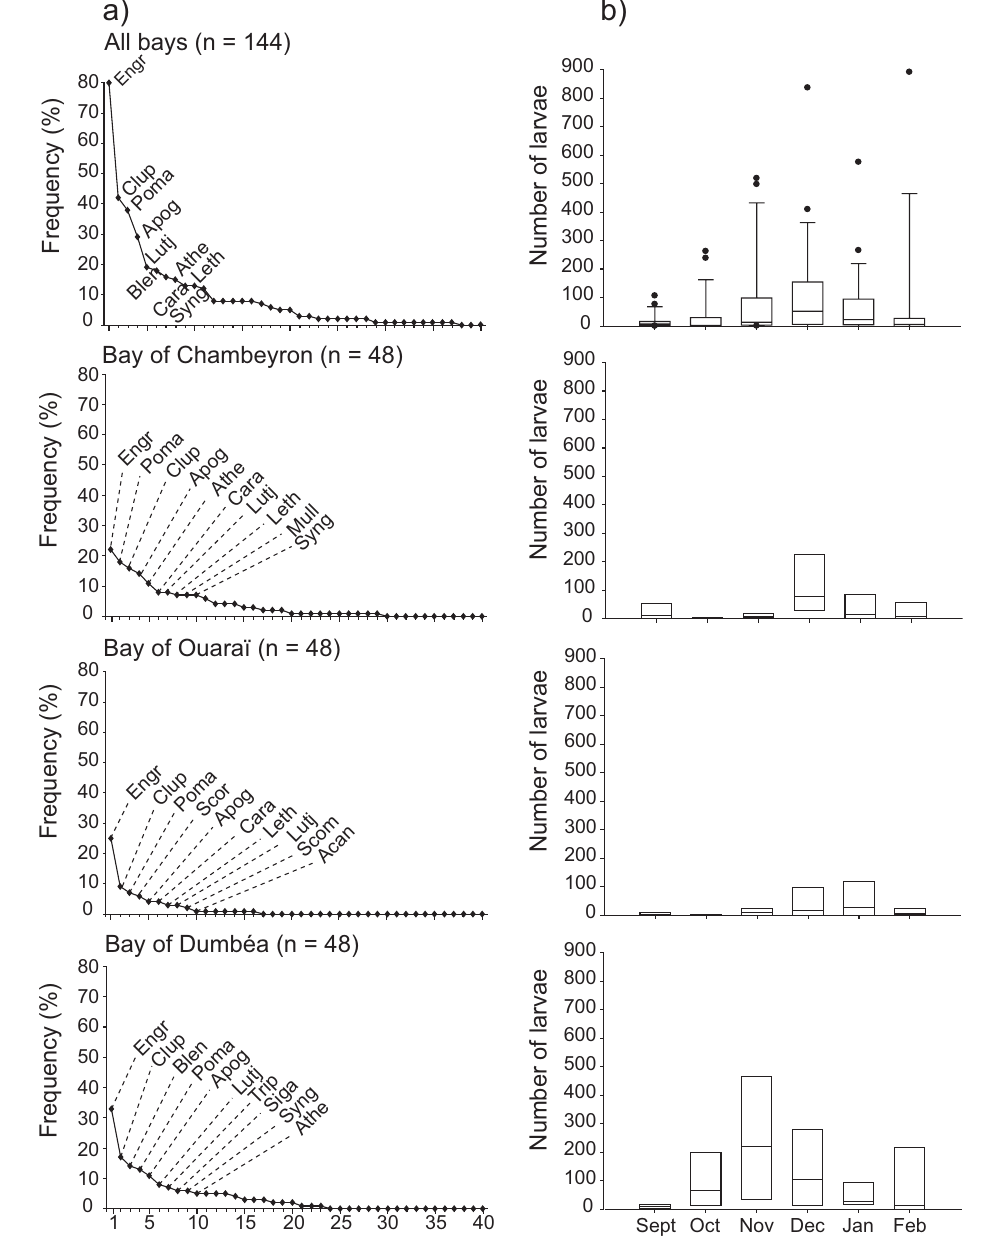
F IG . 4. – Frequency of occurrence of larval fish families (left column) and monthly variations of total larval fish abundance (right column) in a) all bays, b) in the Bay of Chambeyron, c) in the Bay of Ouaraï and d) in the Bay of Dumbéa. See Table 2 for family codes. The upper and lower limits of the box plots (right column) represent the first and third quartiles of larval fish abundance data respectively, the horizontal bars indicate the median, the error bars represent the 10 th and 90 th percentiles and the dots represent the values outside the 10 th -90 th percentile